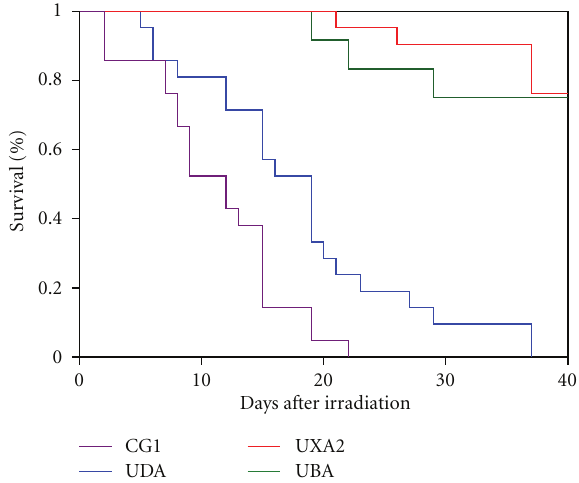
Figure 3: Survival of di ff erent zebrafish lines in response to radia- tion. Kaplan-Meier survival curves are shown for four di ff erent zebrafish strains after irradiation with a total dose of 25 Gy, deliv- ered in two equal fractions of 12.5Gy separated by 24 hours. Twenty one fish were irradiated in each group. CG1 is a clonal homozygous diploid fish line generated by parthenogenesis [21, 38]. UDA, UXA2, and UBA are inbred zebrafish lines derived from a single mating pair of AB parents [35]. Each line was named for the homozygous class I MHC gene at its chromosome 19 locus. The results demonstrate 100% mortality for the CG1 fish by day 22, and by day 37 for the UDA fish. In contrast, the UBA and UXA2 fish lines both had approximately 80% survival at 40 days after